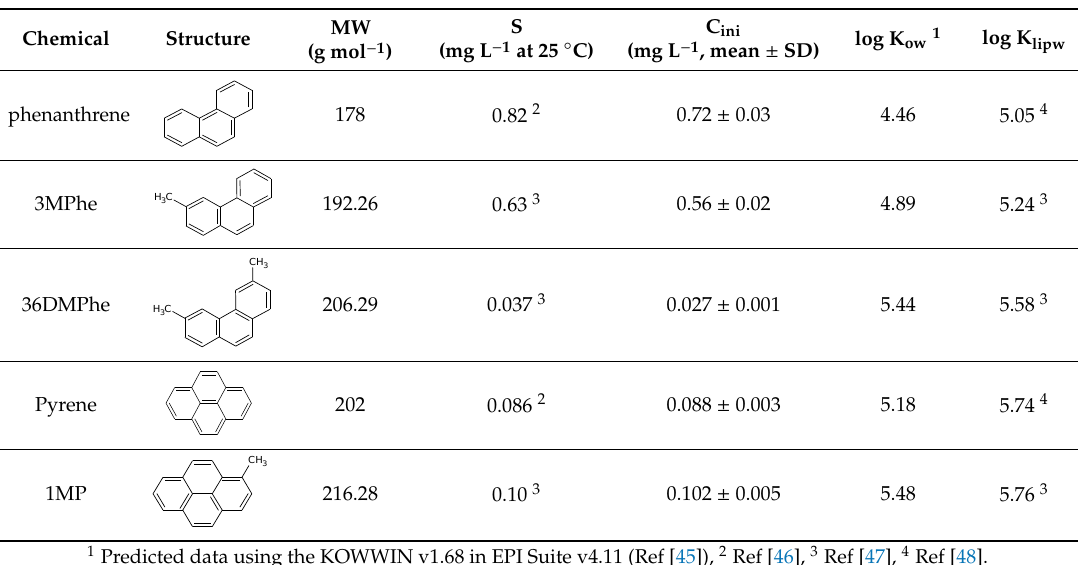
Table 1. Chemical structure, molecular weight (MW), aqueous solubility (S), the initial concentration in biodegradation tests (C initial ), logarithm of octanol-water partition coefficient (log K ow ), and lipid-